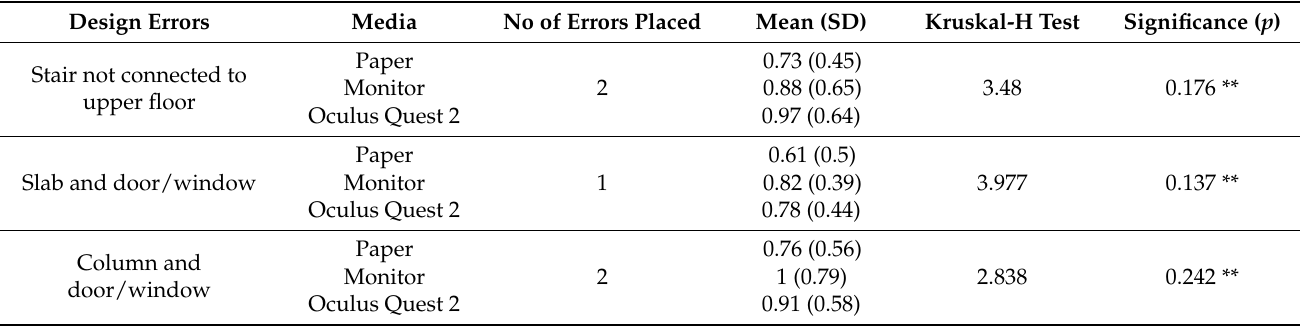
Figure 8. Average task completion time. Table 4. The number of design errors identified by the three design review